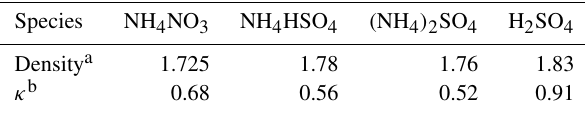
Table 1. Aerosol properties of selected compounds used for the cal- culation of the hygroscopicity parameter κ , i.e., the density ( ρ i ) and ( κ i ) of each